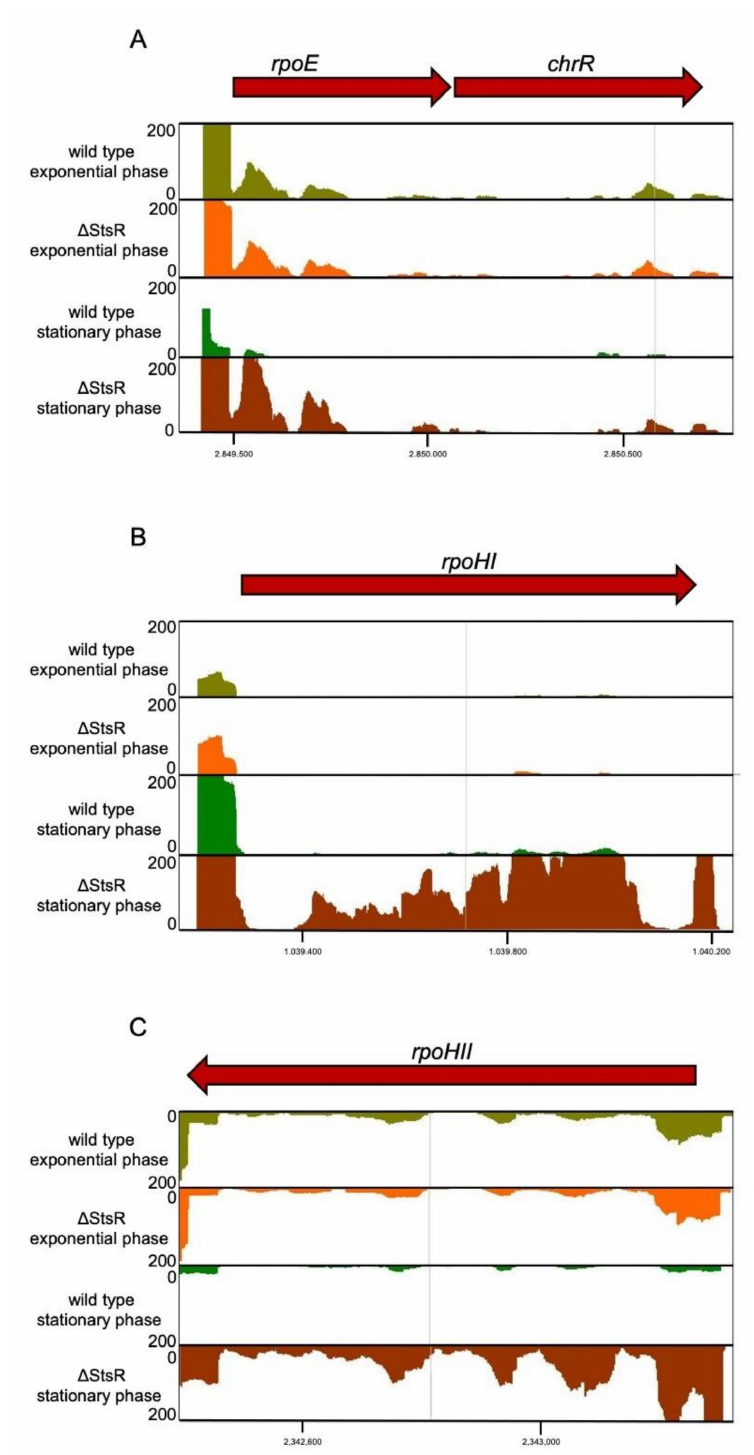
Figure 4. Effect of StsR on expression of selected genes for alternative sigma factors. Normalized read numbers from RNAseq visualized by the Integrated Genome browser are shown for ( A ) rpoE and chrR genes encoding a sigma factor and its antisigma factor, ( B ) the rpoHI gene and ( C ) the rpoHII gene encoding alternative sigma factors with an important role in stress responses. Reads are shown for RNA isolated from the wild type or a mutant lacking StsR ( ∆ StsR) in the exponential or stationary phase 72 h after inoculation. The read counts within one panel were all normalized to the same scale, as